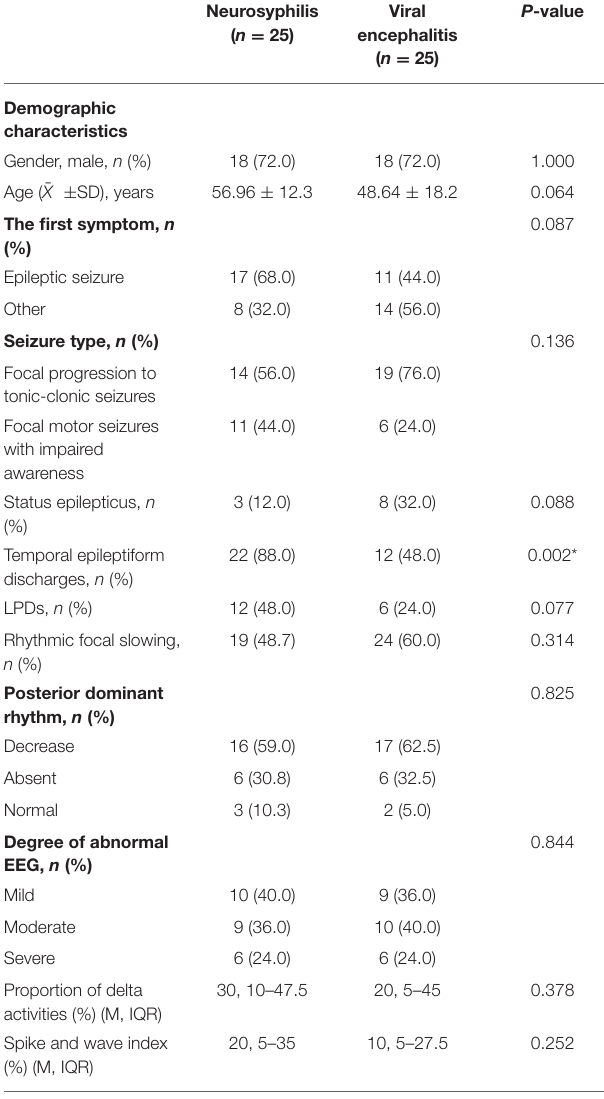
TABLE 2 | Comparison of EEG characteristics between patients with seizures caused by neurosyphilis and viral encephalitis. Neurosyphilis ( n = 39)